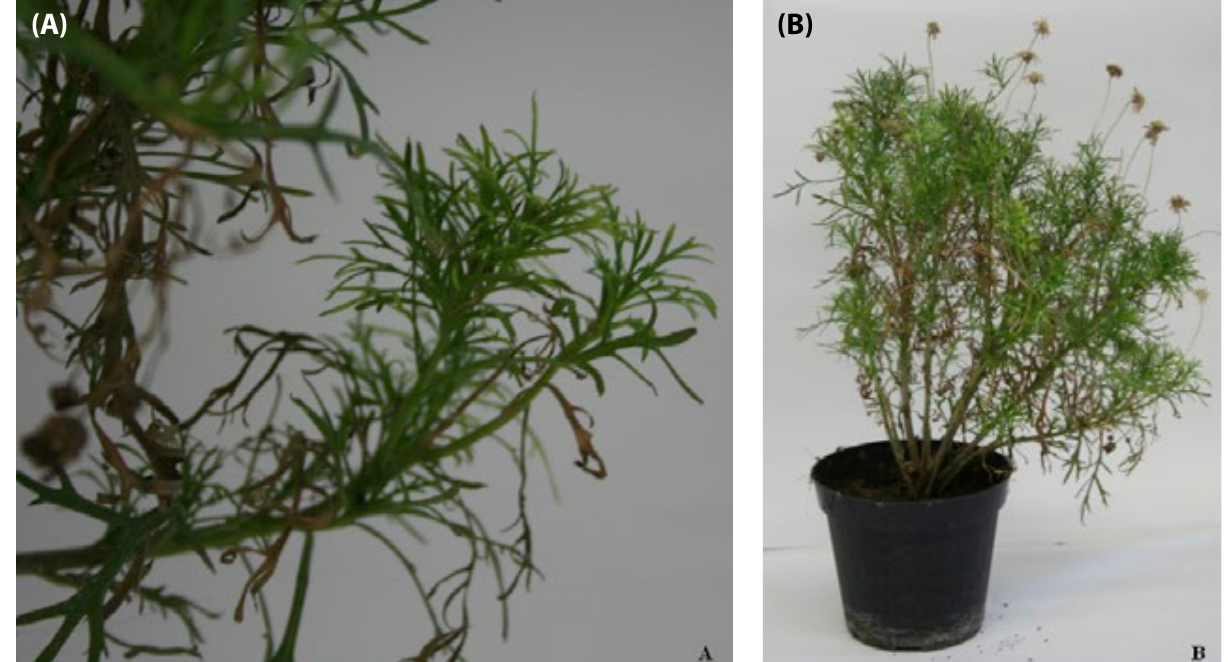
Figure 1. Proliferation of axillary shoots (A) resulting in the appearance of witches’ broom (B) in Argyranthemum frutescens plants infected by Picris echioides yellows phytoplasmas